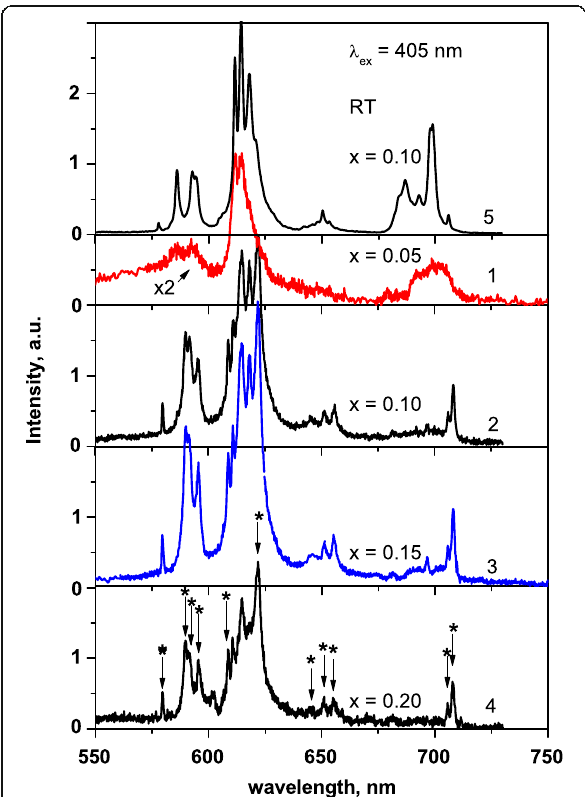
Fig. 7 Emission spectra of the La 1 − x − y Eu y Ca x VO 4 ( 1 – 4 ) and La 1 − 0.2 ( 4 )